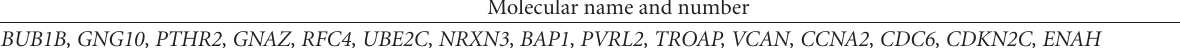
Table 2: Activated PTHLH feedback-mediated cell adhesion molecular network and numbers in HCC from the same activated PTHLH GO-molecular network of HCC compared with the corresponding activated GO-molecular network of no-tumor hepatitis/cirrhotic tissues by our programming.